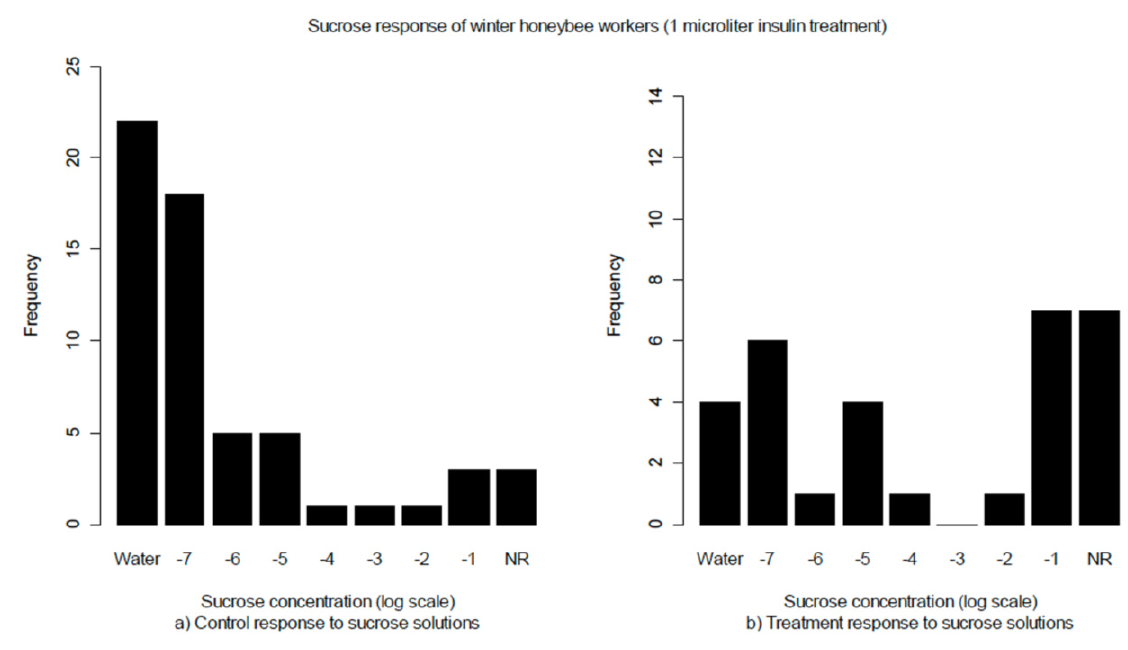
Figure 1. Sucrose response threshold of winter honeybee workers. The two types of controls, untreated and sham treated, did not differ significantly and are grouped together in the figure. NR = no response. There is a significant difference between the sucrose response thresholds of the controls ( a , n = 60) and insulin treatments ( b , n = 31) (X 2 = 6.4532, p =